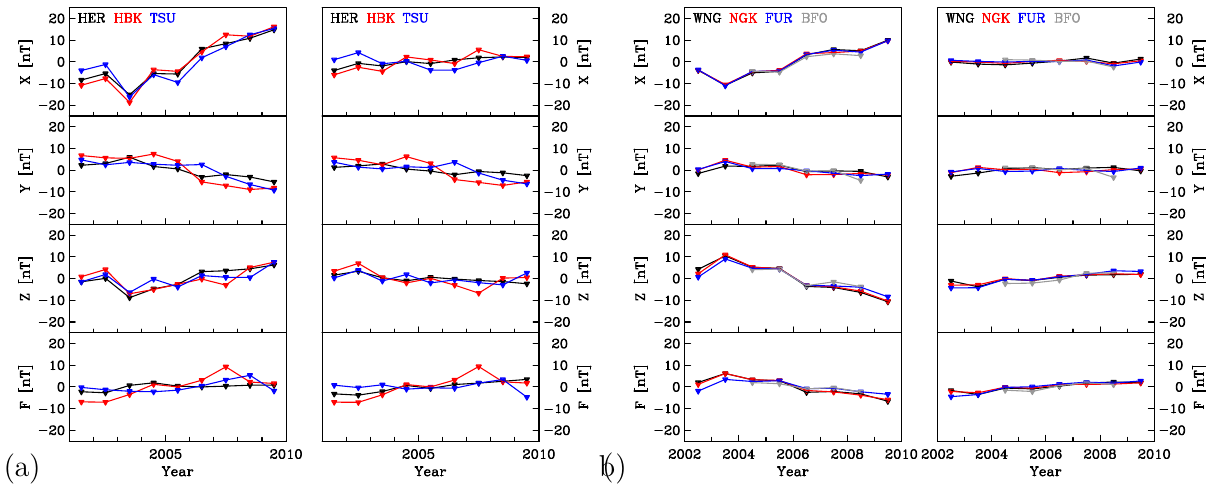
Figure 2. Residuals of (a) southern African and (b) German observatory annual mean values after subtraction of GRIMM3 core field predictions (left panels) and core plus magnetospheric field estimates (right panels). Constant average values, representing the estimated lithospheric anomaly values, have been subtracted.